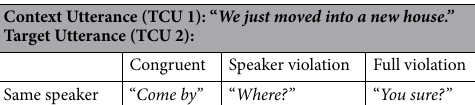
Table 1. Example stimulus from Experiment 1 in the congruent, speaker violation, and full violation